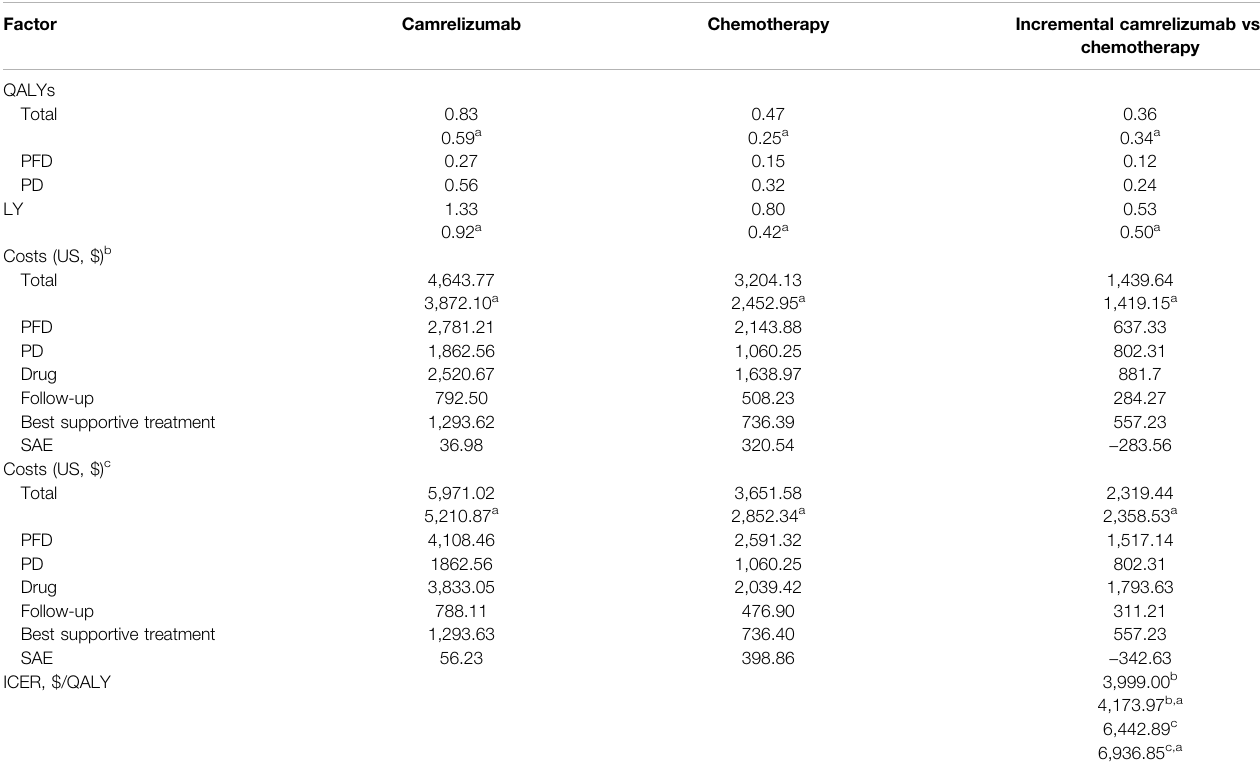
TABLE 2 | Summary of base-case